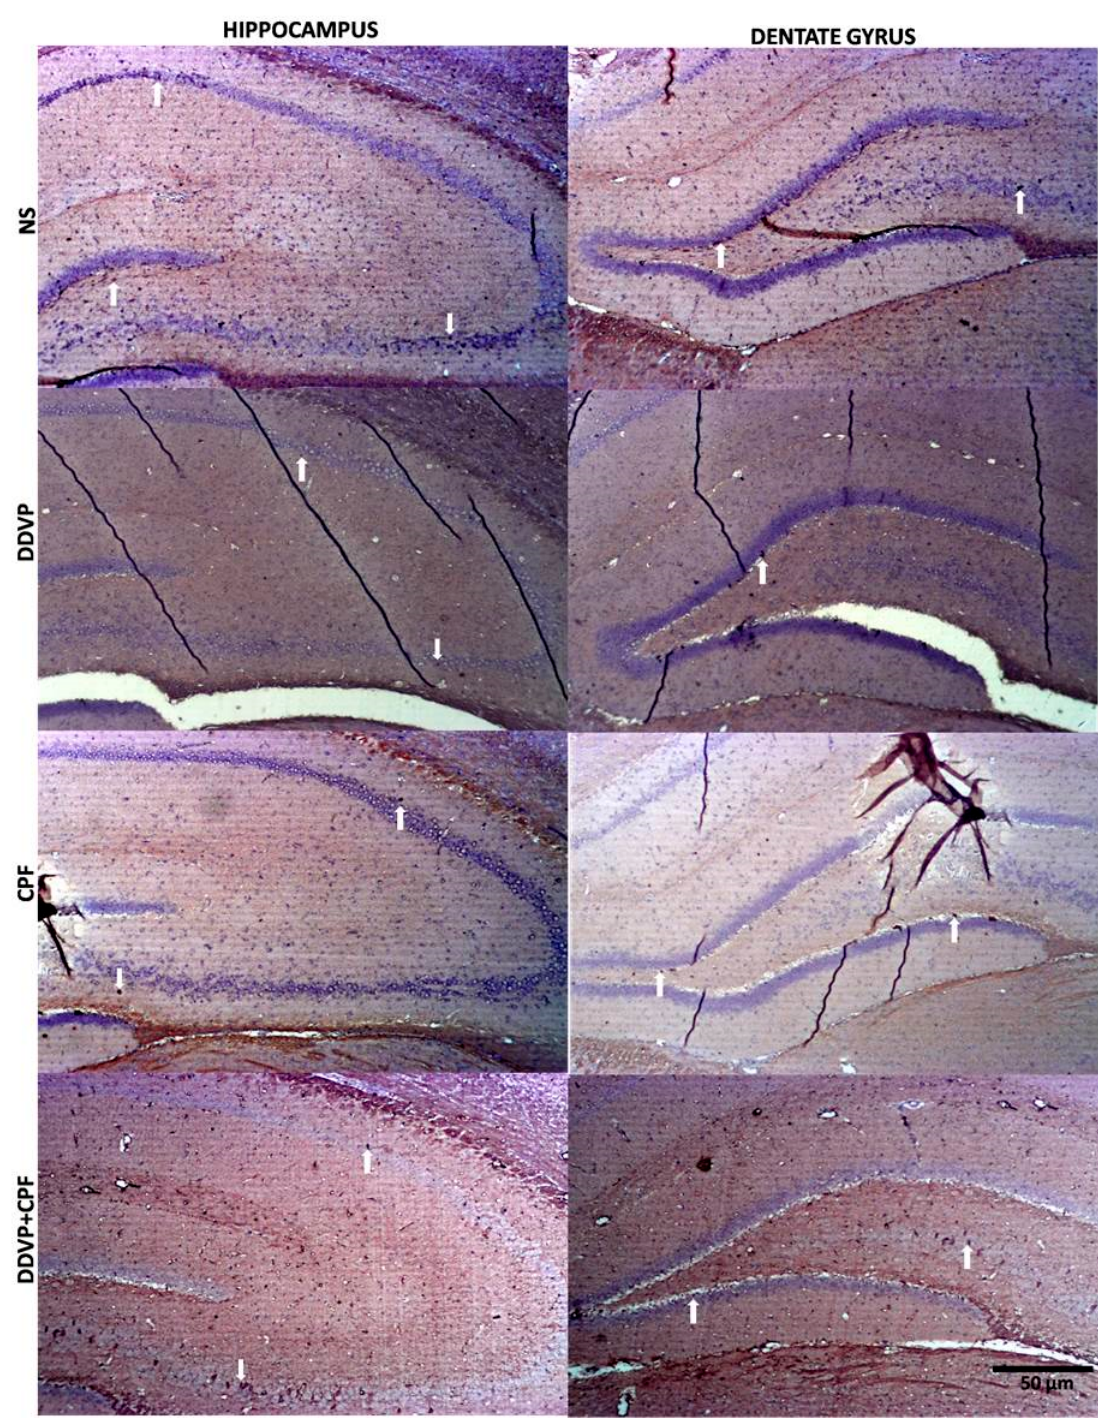
Figure 7. The effects of oral exposures to normal saline (NS), dichlorvos (DDVP), or/and chlorpyrifos (CPF) on: the distributions of Ki67 nuclei proteins in the hippocampal connus ammonis regions (CA1 and 3), and the dentate gyrus (DG) in the exposed rats. White arrows indicate the Ki67 immunoreactive proteins in the respective regions, with reduced nuclei in the DDVP and/or CPF exposed rats compared to the control. Scale bar 50 μ m.